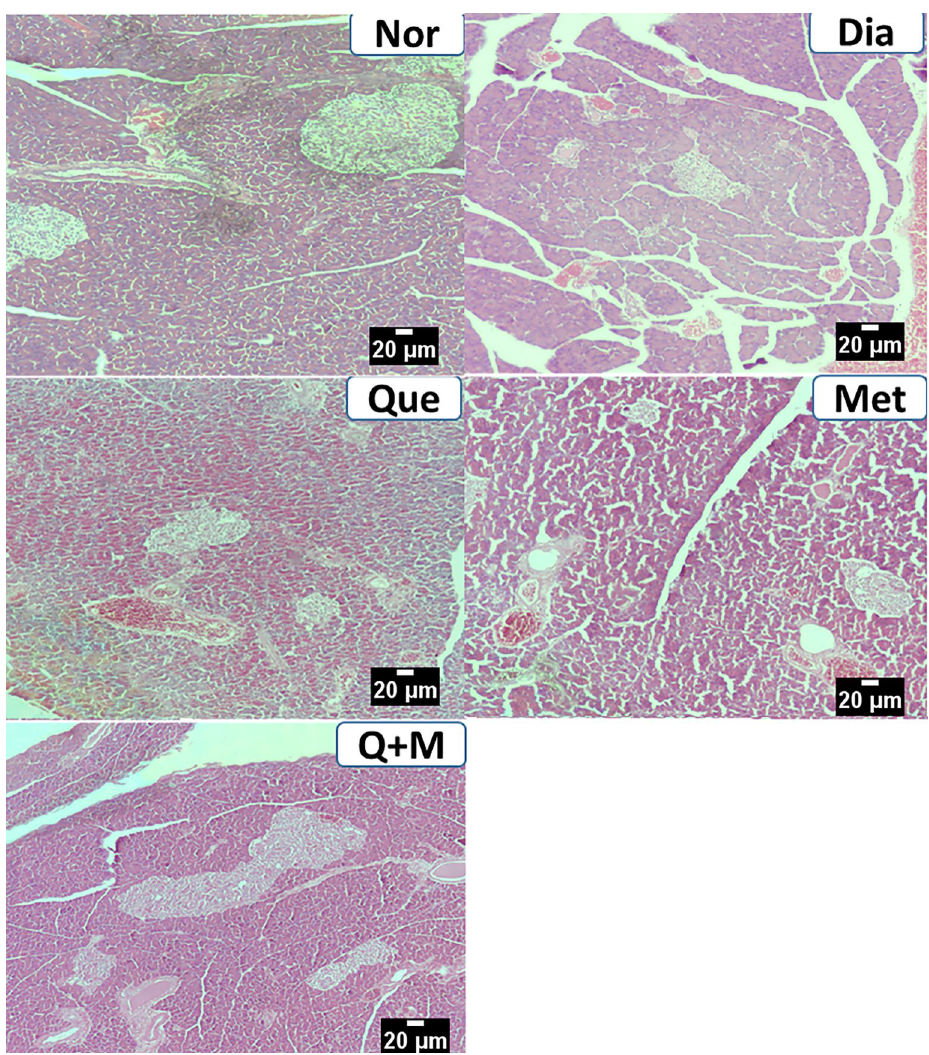
Figure 6. The effect of test compounds on pancreas histology in diabetic rats. Nor Normal, Dia Diabetic, Que Quercetin treated, Met Metformin treated, Q + M Quercetin + metformin treated diabetic